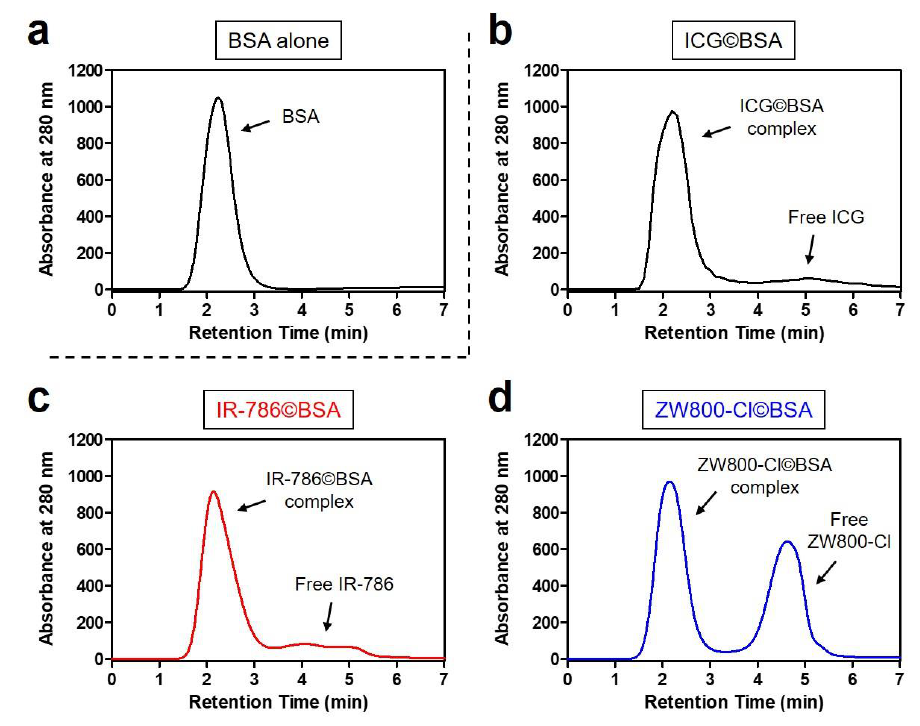
Figure 2. GFC separation of ( a ) BSA alone and its mixtures with ( b ) ICG, ( c ) IR-786, and ( d ) ZW800-Cl. The mixture was incubated at 37 °C for 4 h prior to loading on a separating column. The hydrodynamic diameter of BSA complex was measured at 280 nm using an absorbance spectrophotometer.